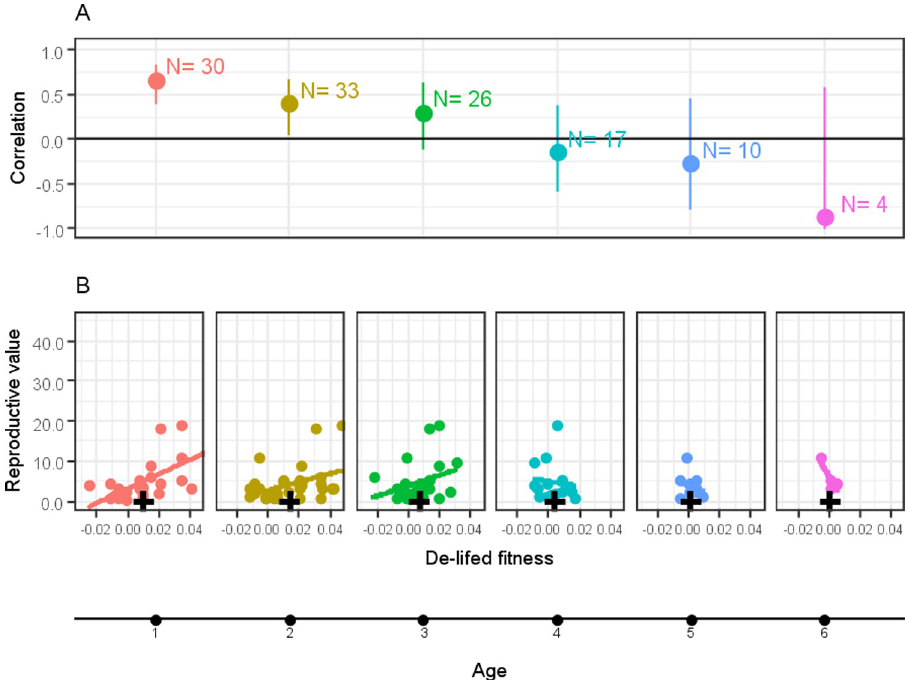
Fig 3. (A) Correlation between reproductive value and de-lifed fitness by age class (in years), with 95% confidence intervals. N represents the sample size. Older age classes have lower sample sizes because fewer individuals survive to that age. (B) Correlation between de-lifed fitness and reproductive value. The black cross represents mean de-lifed fitness for the respective age. Colours represent the same age